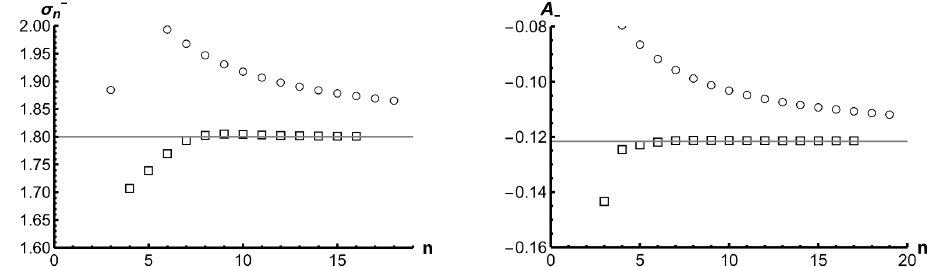
(left) converges to a using (4.9). Using eq. (4.8) we display (right) the Figure 3. The series σ − − n sequence that converges to A . Circle markers indicate the raw data, square markers the second − Richardson transformation. For both, we display results for κ = 0 . 9 . The second Richardson transform converge to the expected results given by eq (4.5) up to errors of 0 . 011% and 0 . 00068%